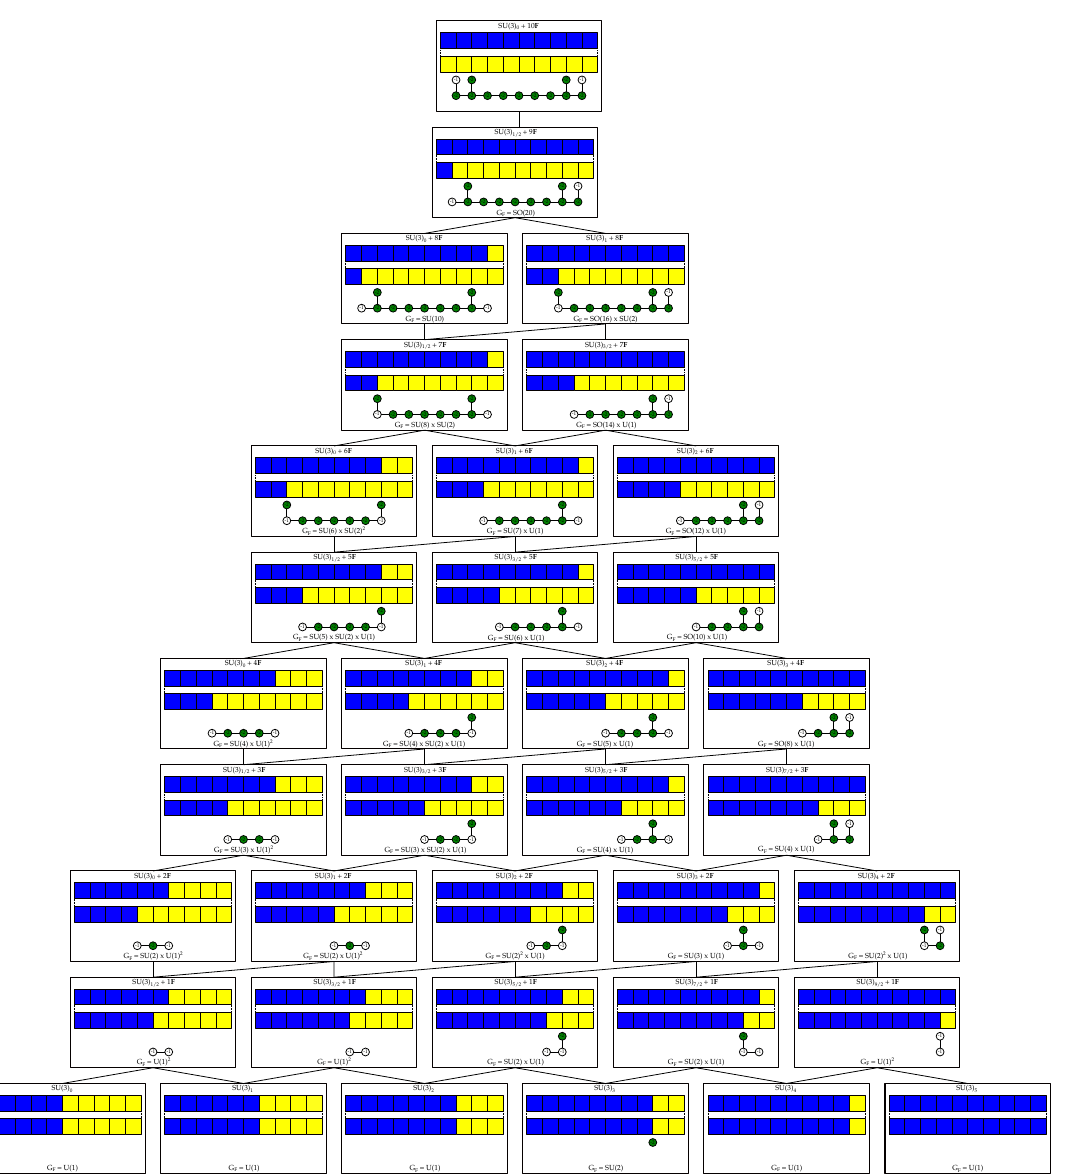
Figure 33. ( D 5 ; D 5 ) Conformal Matter: 5d marginal gauge theory description as SU(3) 0 + 10 F . The ((cid:13)avor-equivalence classes of) box graphs encode the SU(3) gauge theory description of the descendant theory | this is written at the top of each box in the above graph. Knowing that the marginal theory enhances in the UV to the 6d theory of (SO(10) ; SO(10)) minimal conformal matter, which is described by an a(cid:14)ne SO(20) (cid:12)ber, one can determine which of the curves corresponding to the weights of the ( 3 ; N ) representation (where N is the number of (cid:13)avors in that (cid:13)avor-equivalence class), and which of the F i associated to the roots of the a(cid:14)ne SO(20) are contained inside of the non-(cid:13)at surfaces. The intersection pattern of these curves is depicted via a dual graph in the lower half of each box. The superconformal (cid:13)avor symmetry, G F is obtained from the reduced CFDs, shown below the box